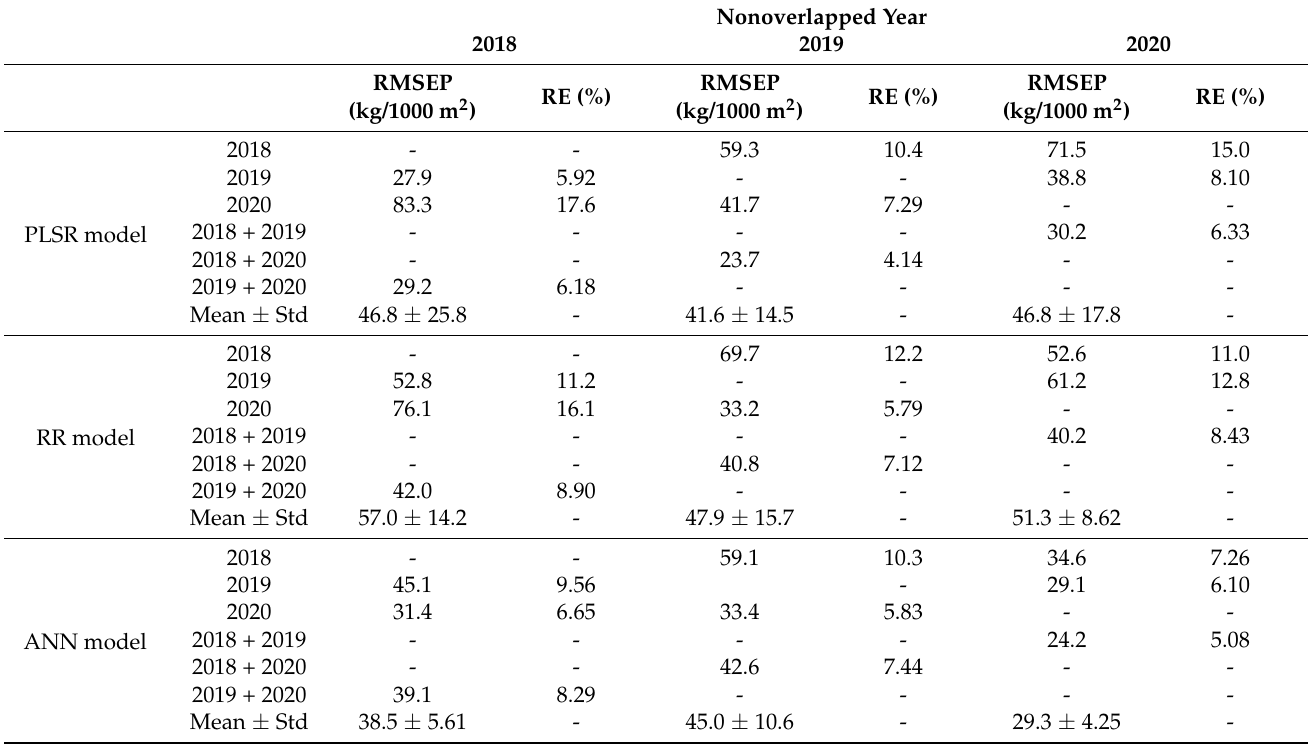
Table 7. Mutual prediction of the rice yield via cross-validation with nonoverlapped years using PLSR, RR, and ANN models in single- and multi-year